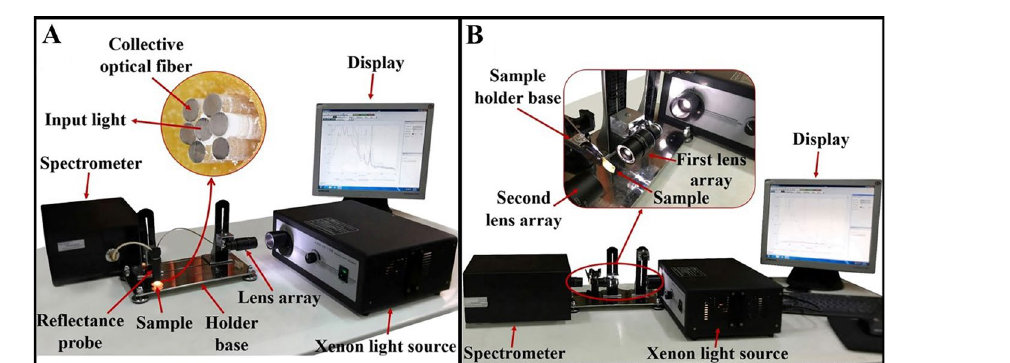
Figure 2. ( A ) Reflectance and ( B ) transmittance spectroscopy